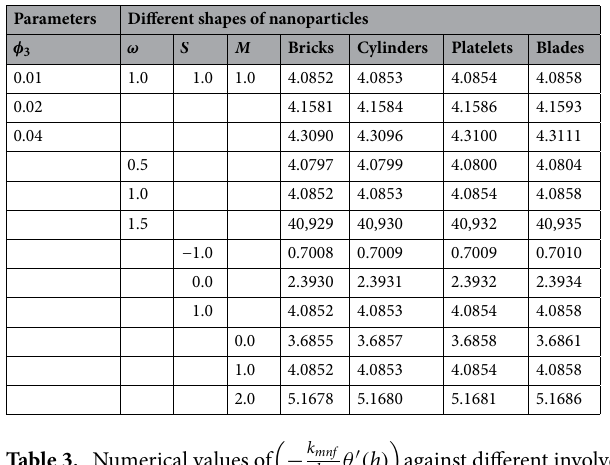
Table 3. Numerical values of